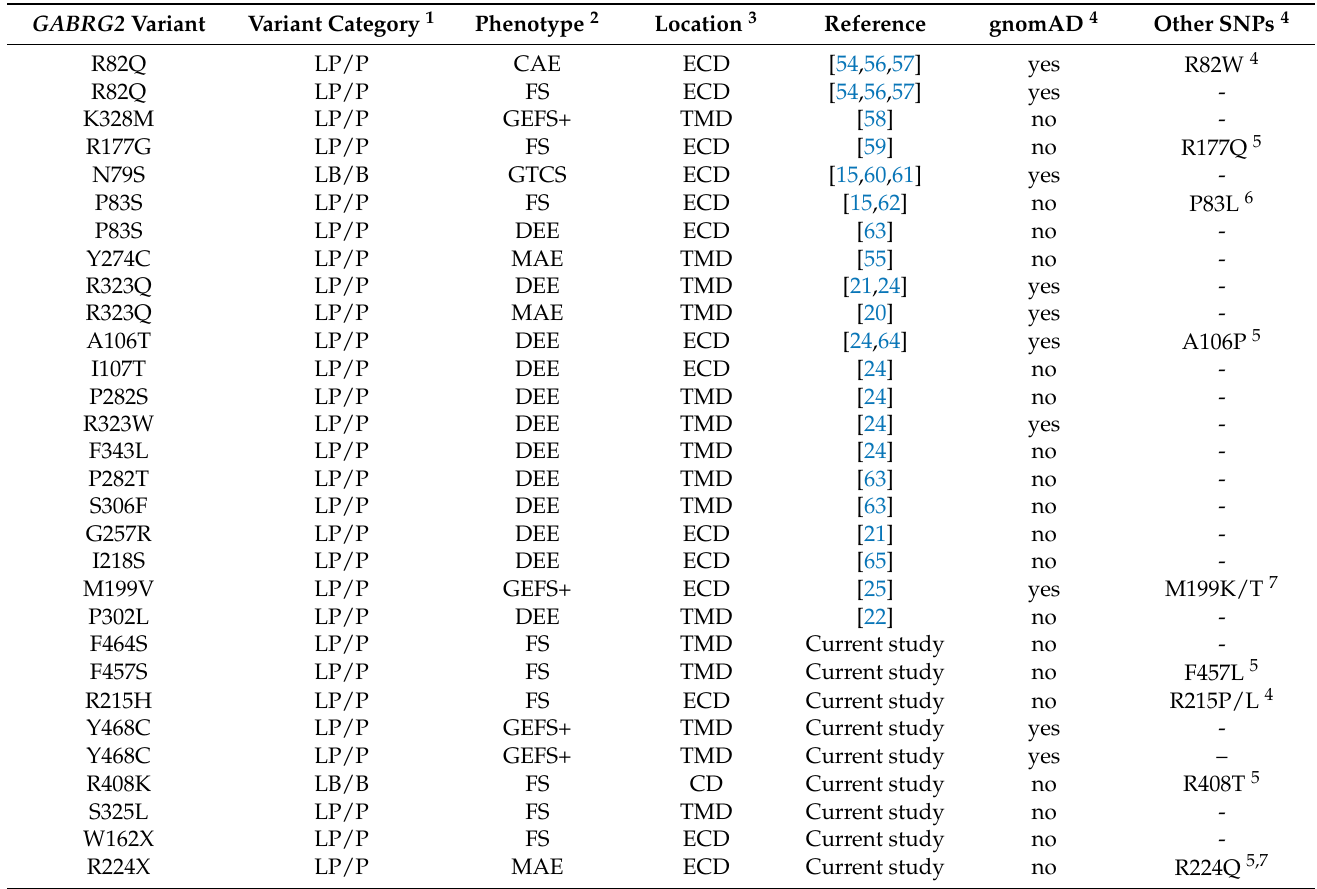
Table 7. Attributes of selected GABRG2 variants found in epileptic